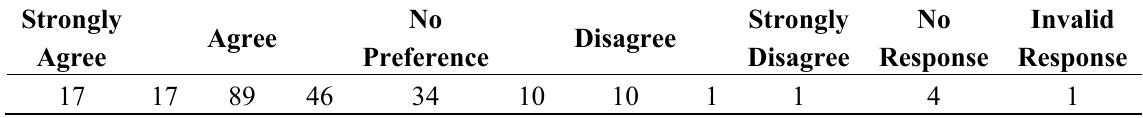
Table 8. Responses to the statement “I would trust computer analysis of data if the software had been tested on Earth and its analysis had been compared to traditional methods”.